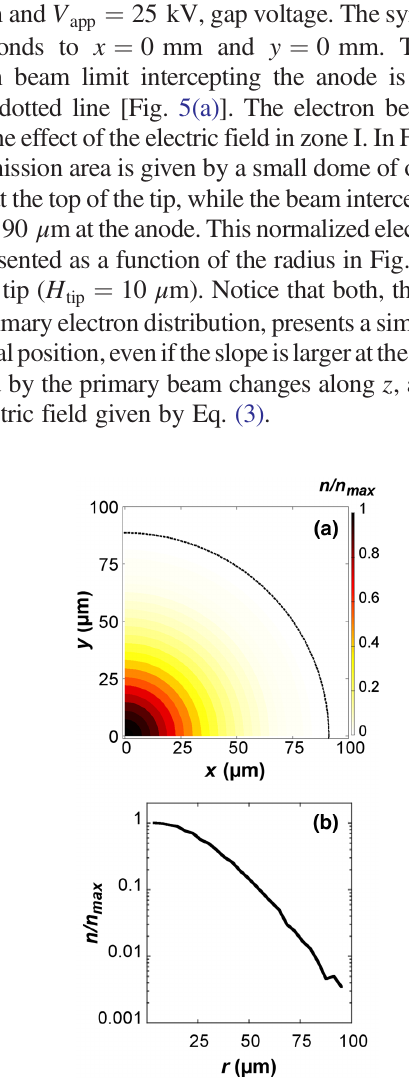
FIG. 5. (a) 2D polar distribution of the normalized surface number density of electrons impinging the anode (color scale of top panel) and (b) the same distribution expressed versus radial